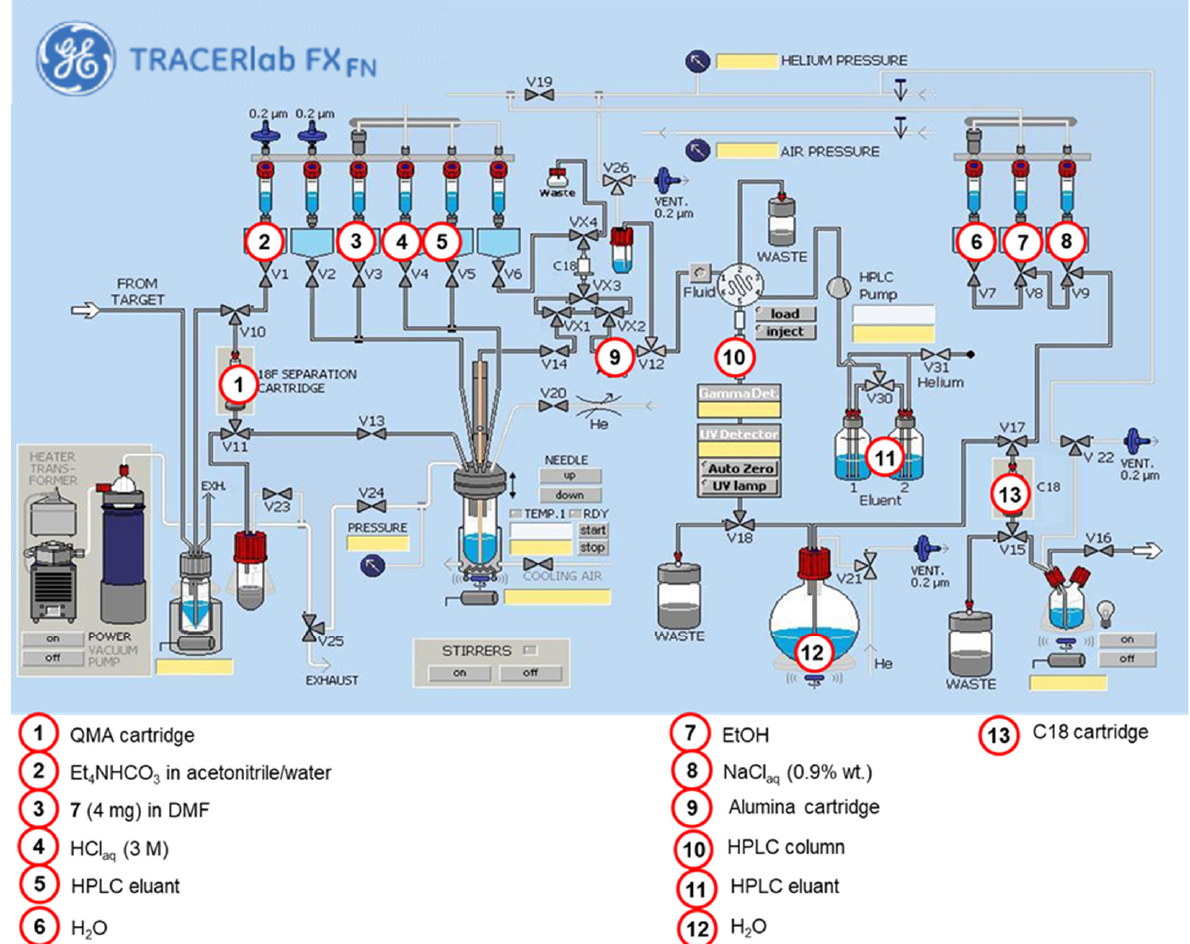
Figure 2. Automated radiosynthesis of [ 18 F] (R,S) -crizotinib on a TRACERlab ® FX FN module.